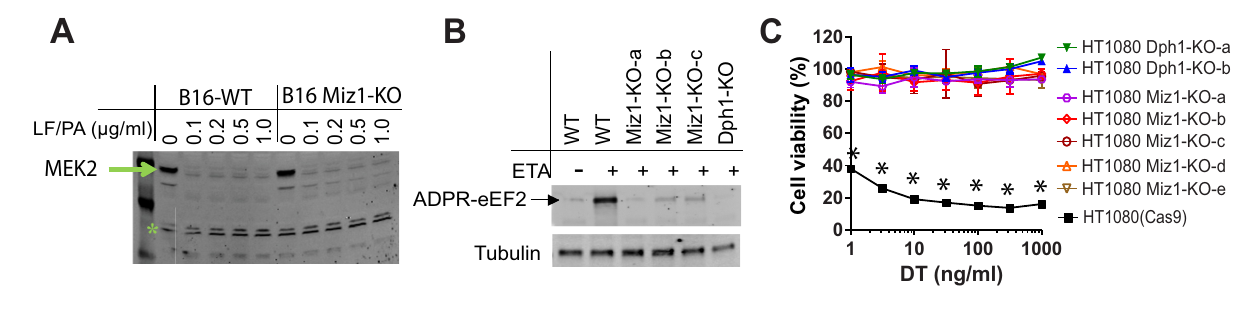
Fig 3. Miz1 is essential for diphthamide modification. A . Miz1 is not required for the toxin entry. B16F10 WT and Miz1-KO cells were incubated with various concentrations of PA/LF for 2 h, then cell lysates were analyzed by Western blotting using an antibody against the N-terminus of MEK2. Of note, LF could normally be delivered into B16 Miz1-KO cells, resulting in MEK2 cleavage (disappearance of MEK2). A non-specific band (indicated by � ) served as a loading control. Representative of three independent experiments. B . eEF2 in Miz1-deficient B16F10 cells could not be ADP- ribosylated by ETA (FP59). The cell lysates from indicated cells were treated with FP59 in the presence of Biotin-NAD + for 30 min and then analyzed by Western blotting using streptavidin-IR conjugate. Three independent B16F10 Miz1-KO clones were analyzed along with a B16F10 Dph1-KO clone as an additional control. Representative of three independent experiments. C . Miz1-deficient HT1080 cells were resistant to DT. HT1080 WT and Miz1-KO cells were incubated with various concentrations of DT for 48 h, followed by MTT assay evaluating cell viability. Five independent